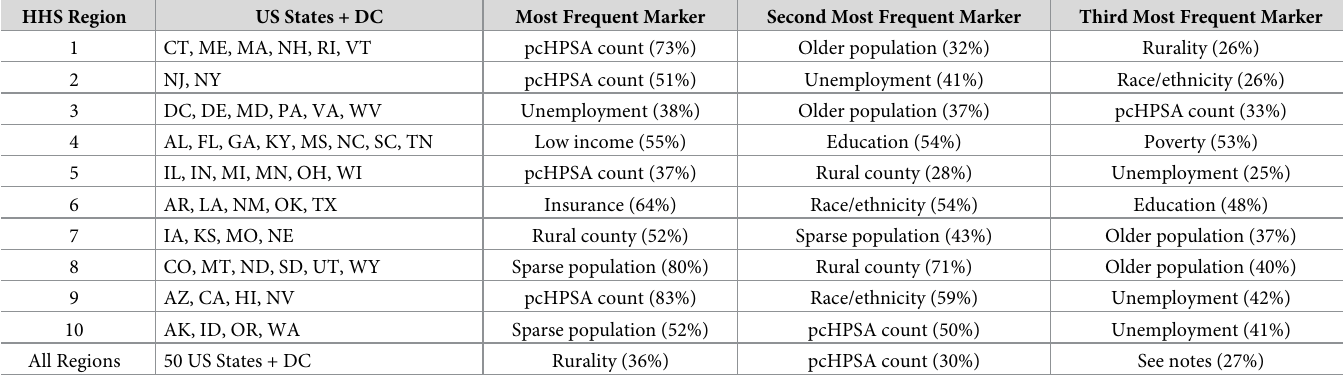
Table 3. Predominant SDOH markers in pcHPSA counties, by HHS Region,